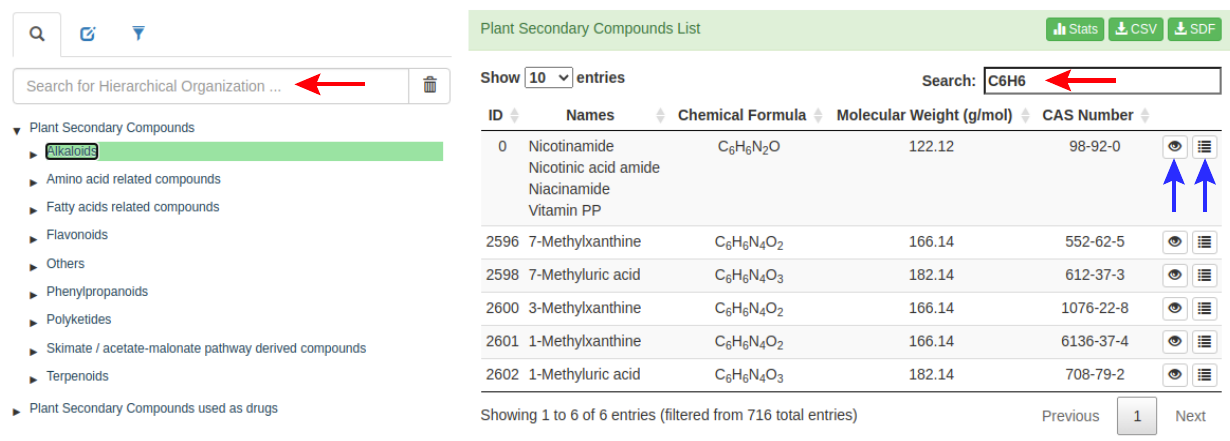
Figure 2. Selection of multiple compounds using two different searching tools (red arrows). For each phytochemical compound the PSC-db ID is given, as well as the names, chemical formula, molecular weight, and CAS number (right panel). More detailed information is available through the “eye” and “list” buttons (blue arrows) .